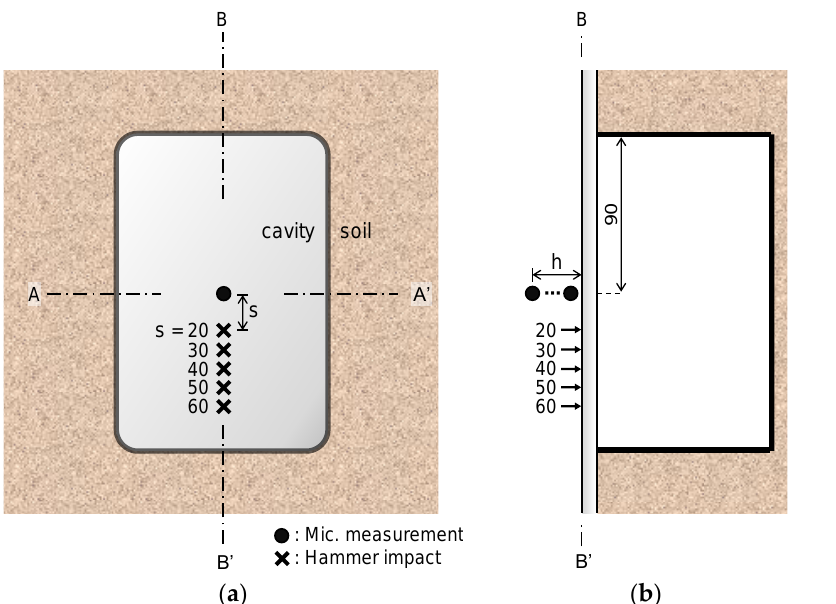
Figure 3. Measurement locations for determination of optimal microphone height and center-to- center spacing between hammer and microphone: ( a ) front view and ( b ) side view. Units are given in mm.